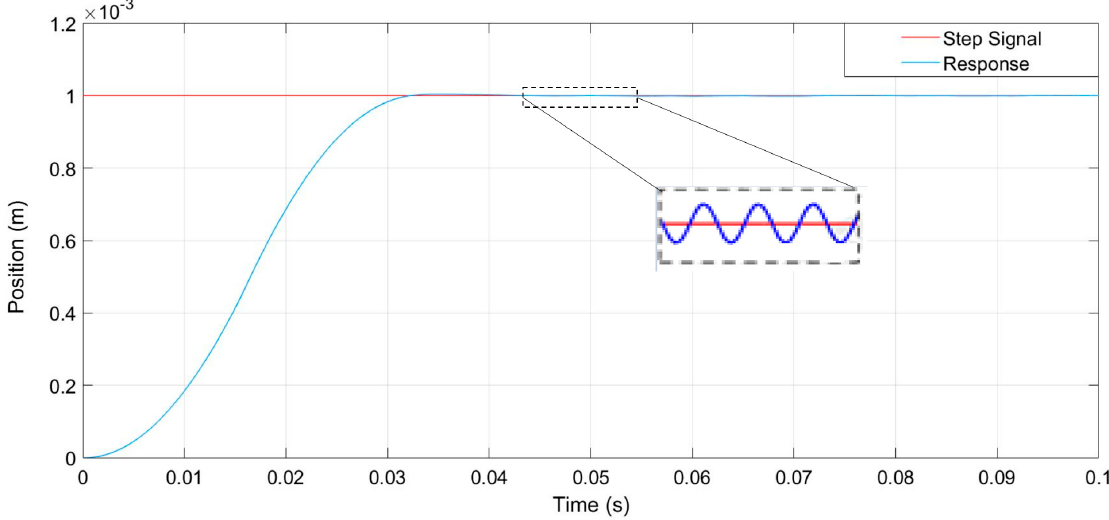
Figure 14. System response under external interference.